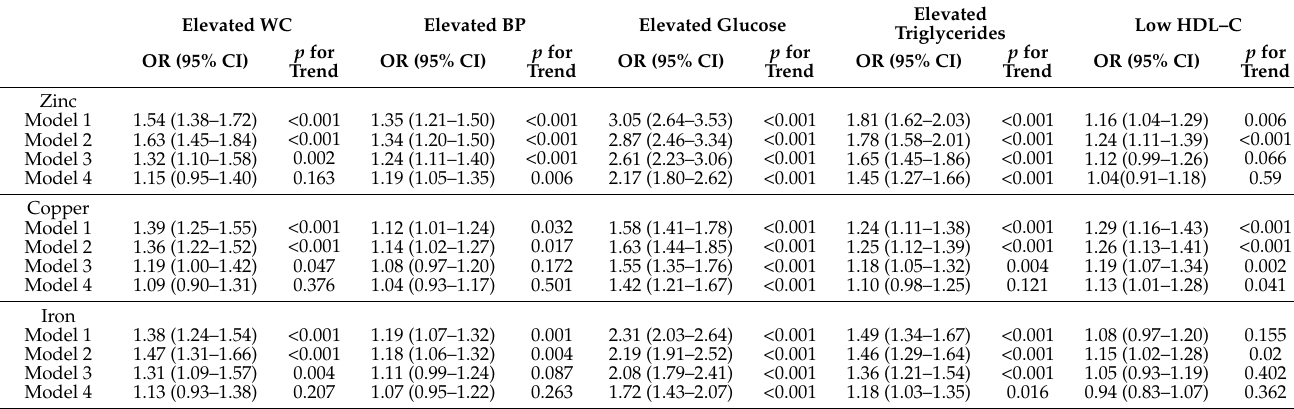
Table 3. Odds ratios of having individual metabolic factors derived from multivariate logistic regression analyses in quartiles of serum zinc, copper, and iron